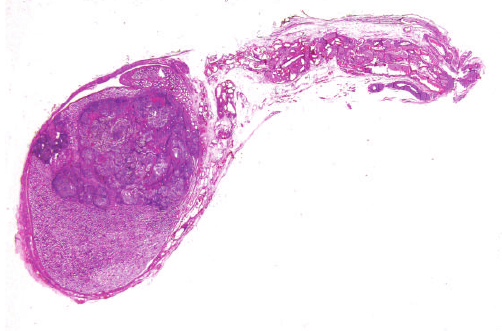
Figure 10: Testicular seminoma: the relationship between the tumour and the tunica albuginea is well evident.